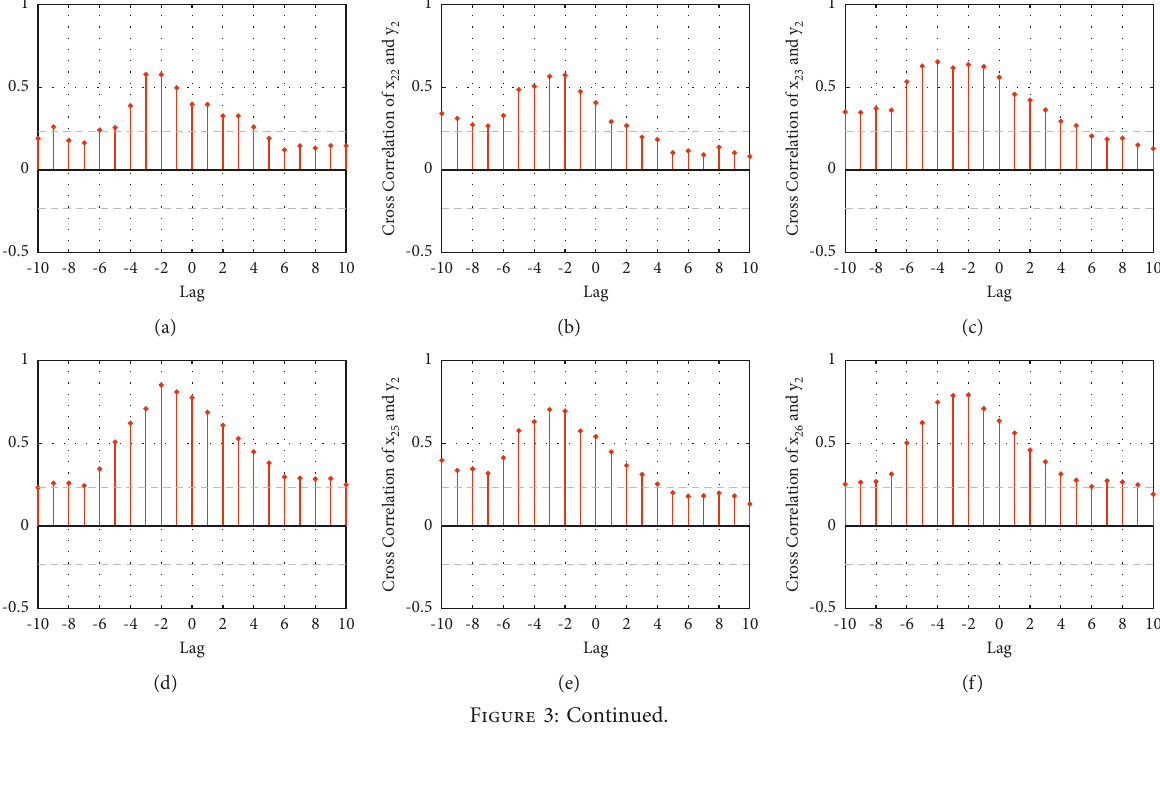
-10 -8 -6 -4 -2 0 2 4 6 8